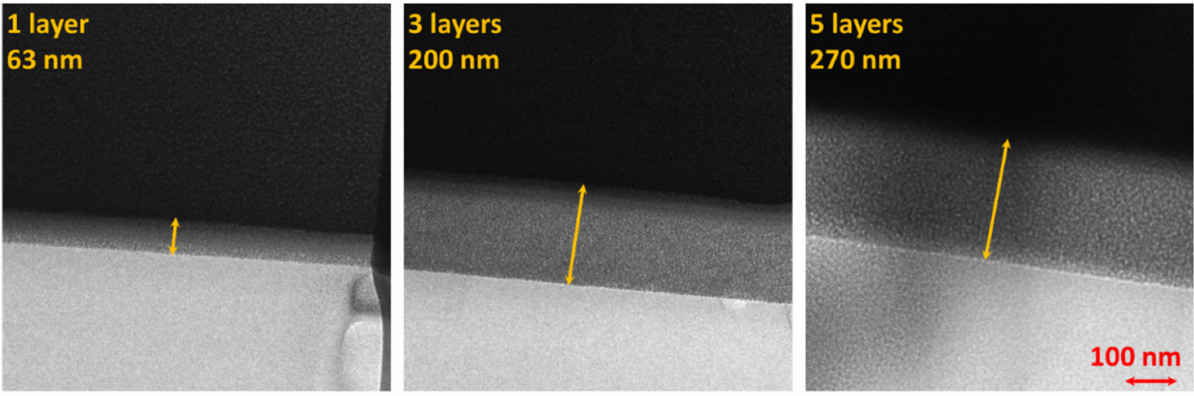
Figure 5. FIB produced cross-section TEM images of one, three, and five photocatalyst layers on PMMA